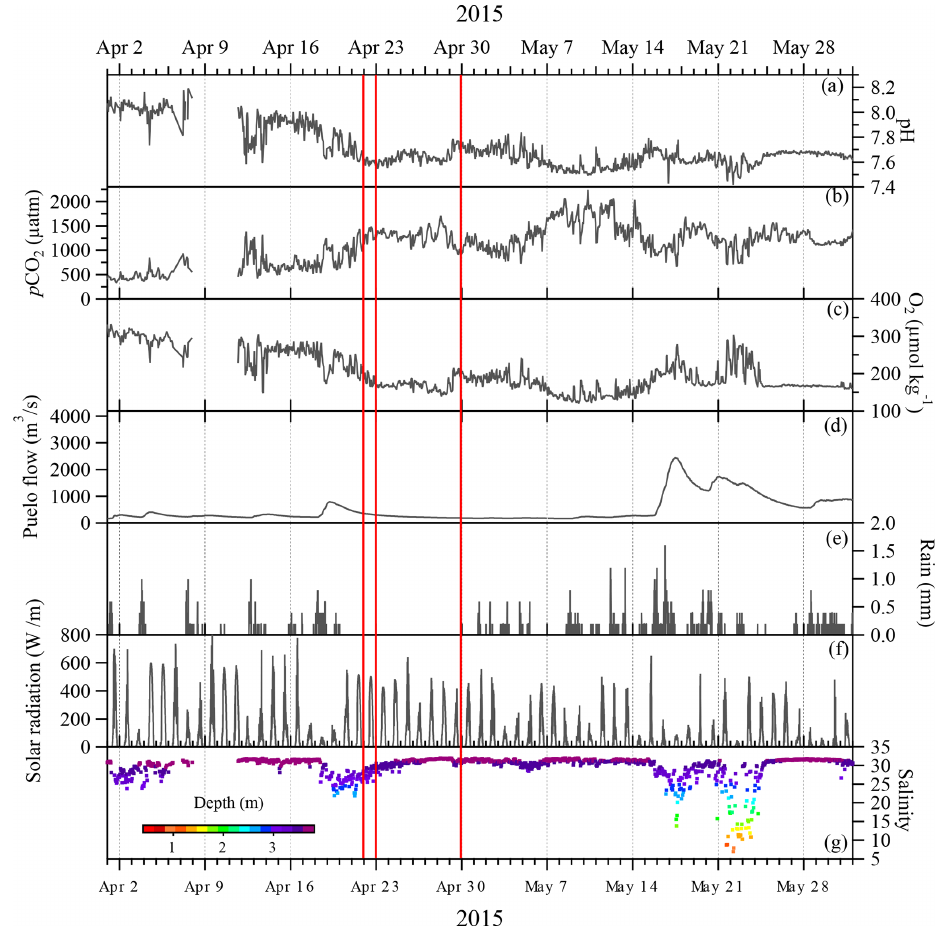
Figure 3. Continuous data from the Reloncaví Fjord mooring and nearby hydrological and weather stations for April–May 2015. The vertical red lines mark the eruption dates. All locations are marked in Fig. 1. Carbonate chemistry and salinity data are from Vergara-Jara et al. (2019). Wind and tidal mixing caused small changes in the depth of the sensors which are shown alongside the salinity